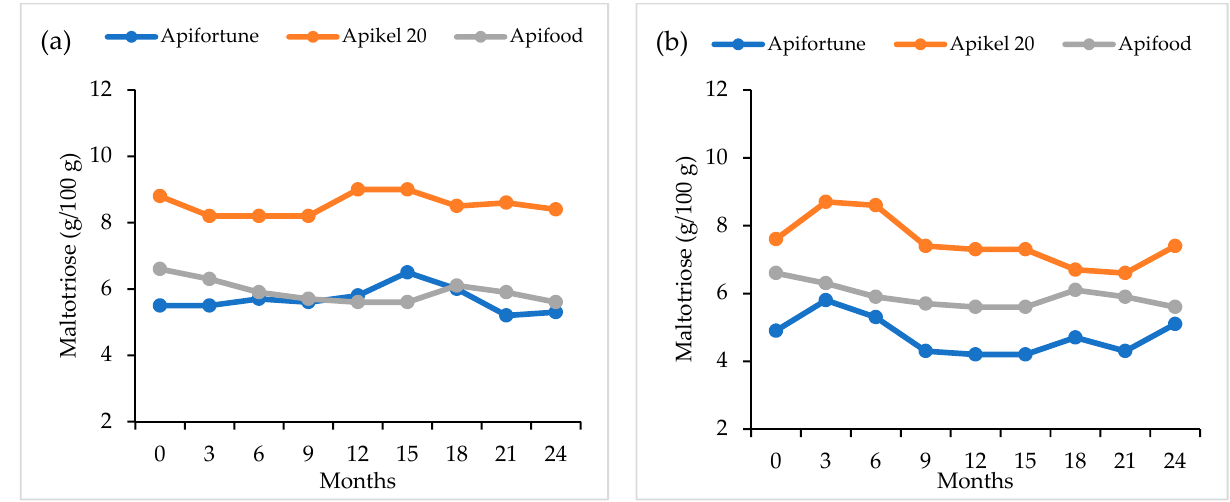
Figure 16. Changes of maltotriose content in syrups during storage at about 4 °C ( a ) from 2012 and ( b ) from 2013.